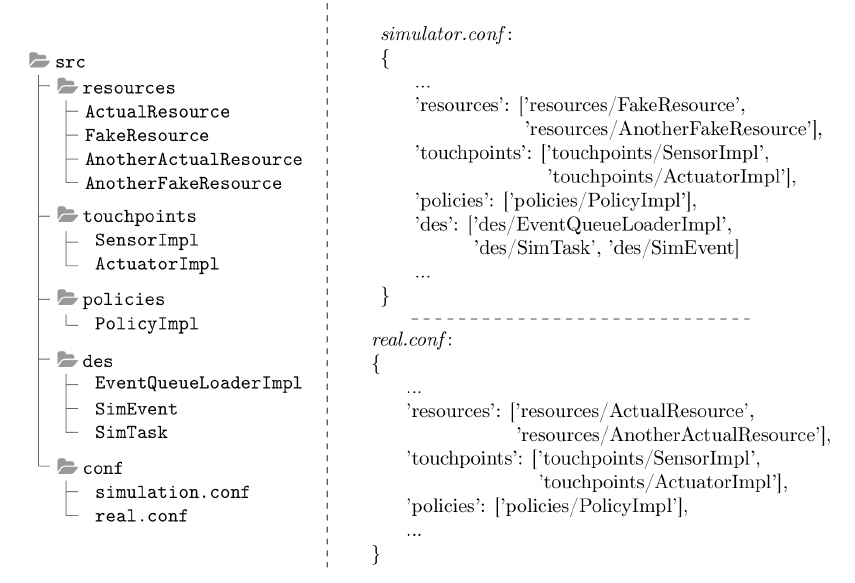
Figure 8. The minimal structure